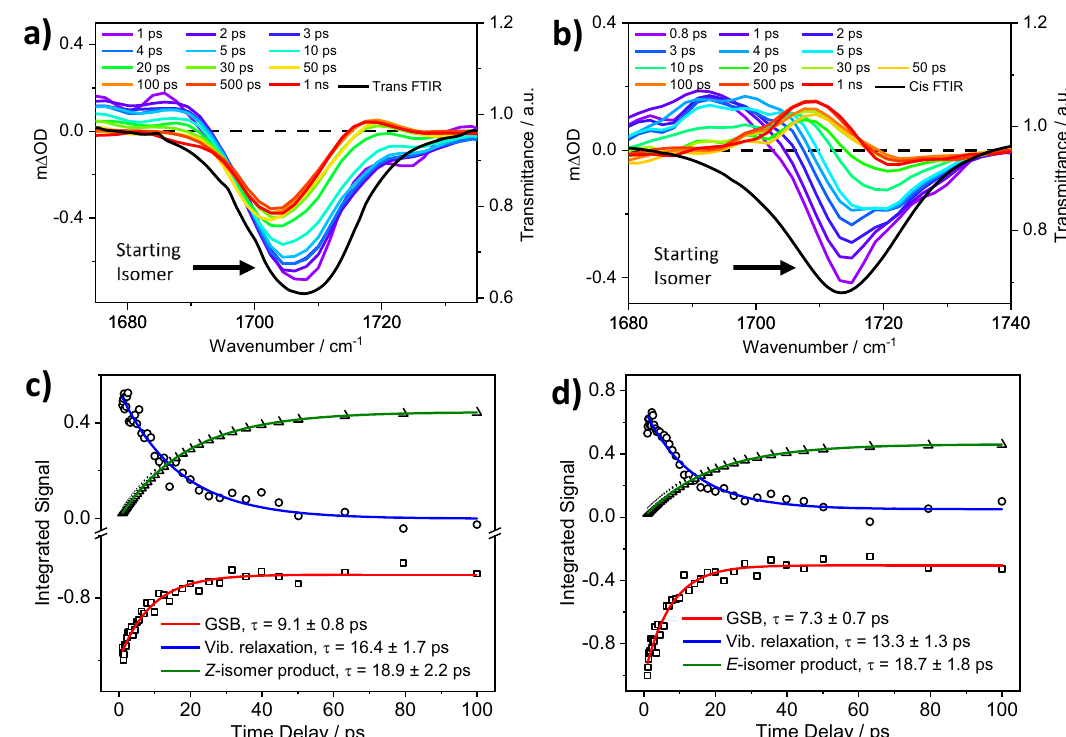
Fig. 2 Transient vibrational absorption (TVA) spectra and exponential fi ttings of E -ES and Z -ES. a E -ES after photoexcitation with 321 nm, and b Z -ES after photoexcitation with 318 nm, both in acetonitrile. The color key in panels a and b shows the different pump-probe time delays. For both TVA spectra, the probe pulse is centered on 1710 cm − 1 . Kinetics of the ground-state bleach (GSB) recovery band of E -ES ( Z -ES), centered at ~1707 (~1713) cm − 1 , vibrational relaxation at ~1680 (~1690) cm − 1 , and photoisomers at 1718 (1708) cm − 1 , obtained using the KOALA software package are shown in c for E -ES and d for Z